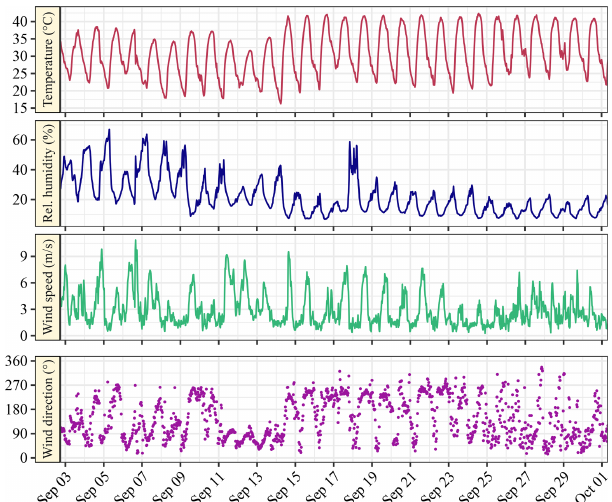
Figure A1. Time series of temperature, relative humidity, wind speed, and wind direction at approximately 2m height. A 30min average is applied on all time series